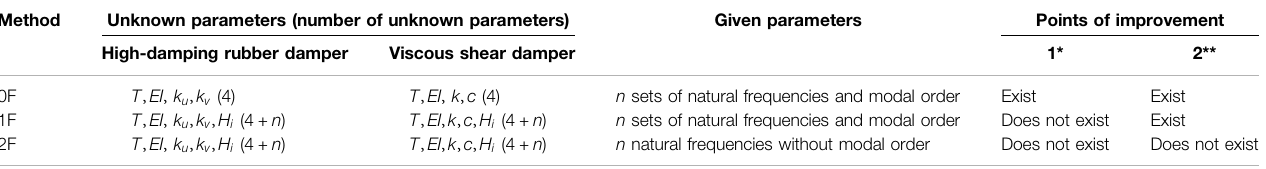
TABLE 1 | A comparison of three tension estimation methods ( i is the modal order and n is the number of natural frequencies). Method Unknown parameters (number of unknown